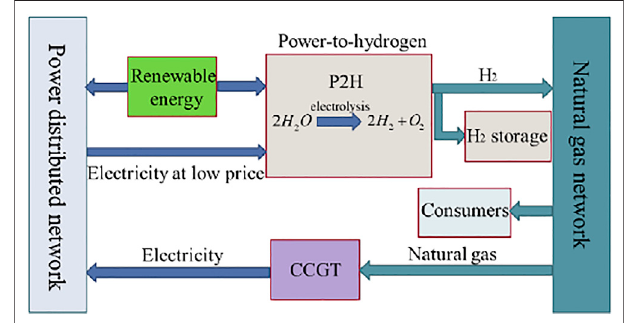
FIGURE 1 | Basic structure diagram of a hybrid renewable energy system.